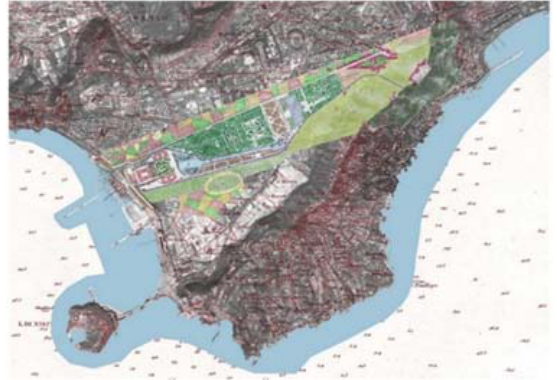
(Figure 2). The utopia of the Anglo-Neapolitan architect will be overturned by a reality that has decreed the environmental destruction of one of the most evocative places in Naples.